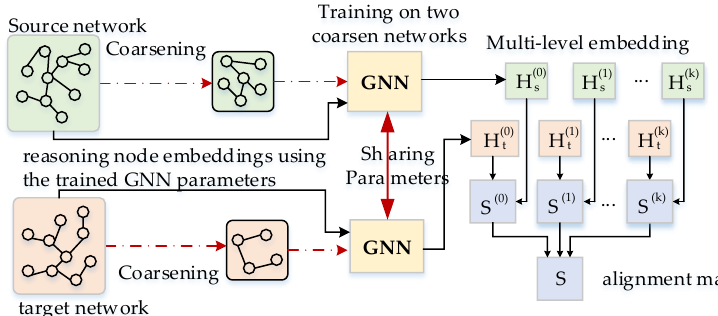
Figure 1. Overview of URNA framework.